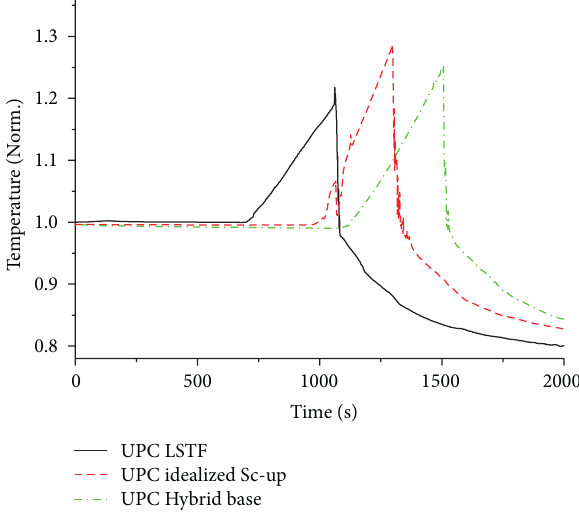
Figure 30: Core exit temperature.